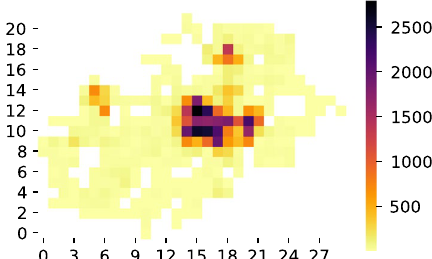
Fig. 1 The territory of the Municipality of Viterbo, tessellated into tiles. The color of each tile show the number of individuals living in the area, only tiles having 10 or more residents are